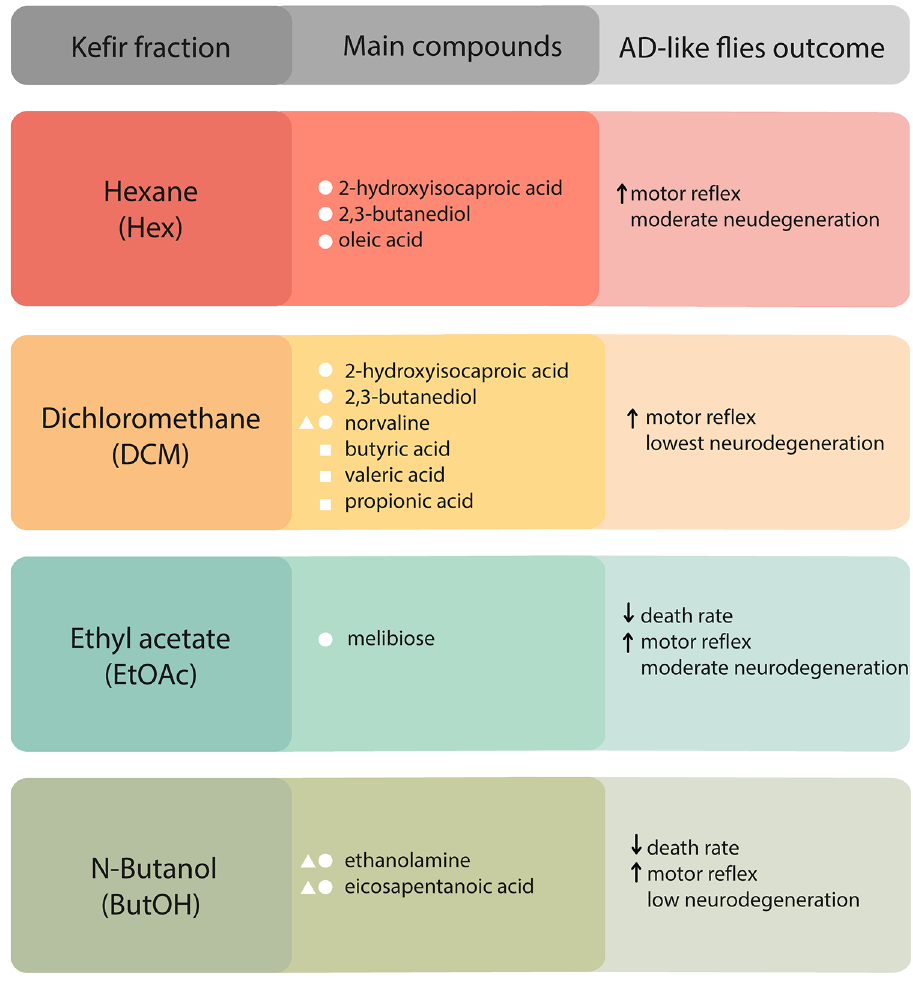
Figure 6. Brief summary of the main compound of each kefir fraction and of the outcome of treated AD-like flies. The compounds were identified by CG-MS, the motor reflex was evaluated by climbing assay, and the neurodegeneration index was evaluated by histopathological analysis. Upwards arrows indicate improvement in the evaluated outcome and downwards arrows indicate its decrease. White symbols indicate the activity of compounds exclusive to each. Squares indicate SCAFS, balls indicate compounds with anti-inflammatory activity, and triangles indicate